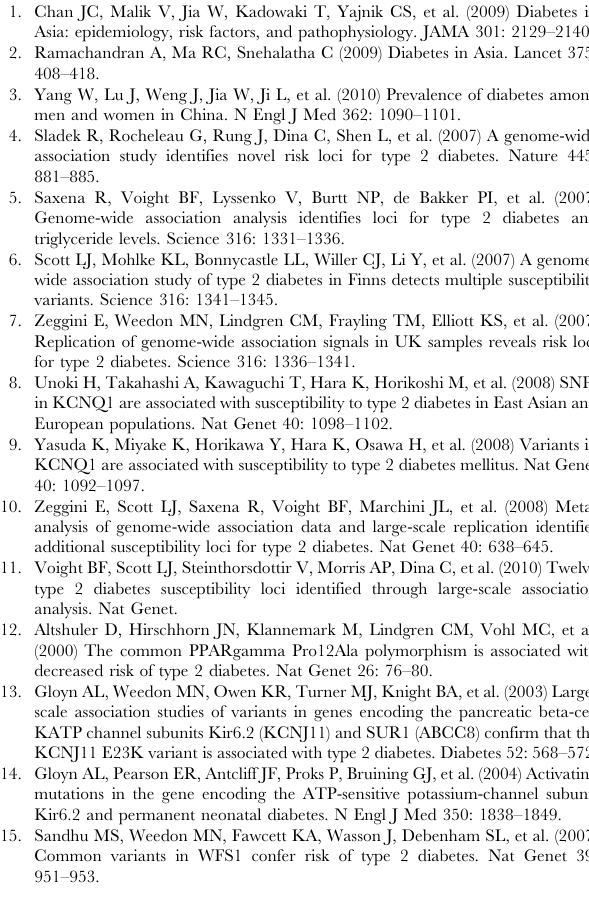
and Asian Indians (MAS) in Singapore and within the three ethnic groups. Table S5 Number of samples excluded during quality control and their reasons for exclusion. Note that the same sample may be excluded for more than one reason and each sample falls into exactly one of the exclusion reasons. Text S1 Description of results from the individual genome